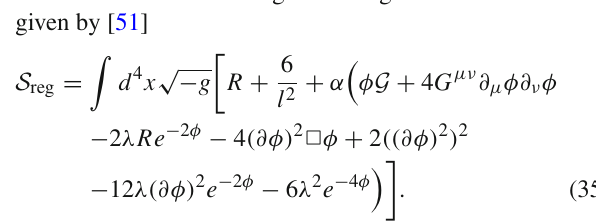
Fig. 8 The critical size r f c of free energy a for negative α and b for positive α in the novel 4D EGB